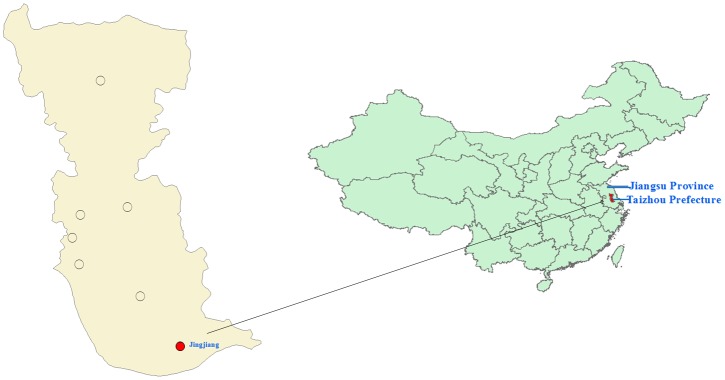
Scrub typhus study site: Jingjiang City, Jiangsu Province, China.